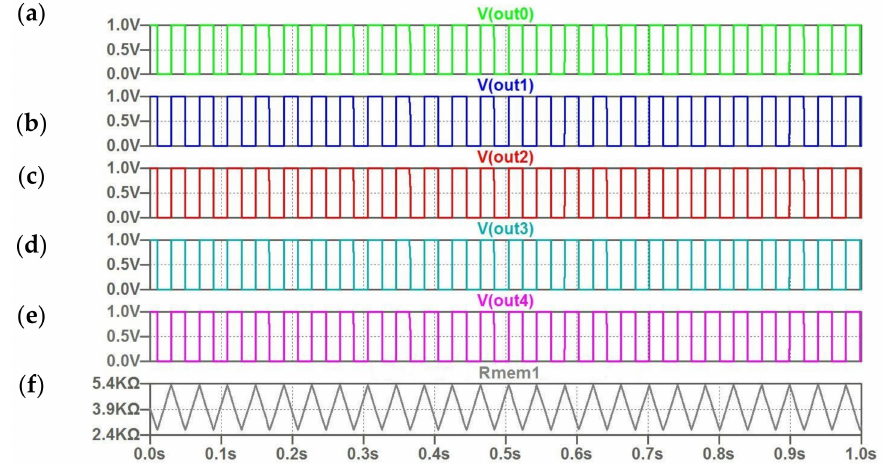
Figure 9. ( a – f ) The computed waveforms for five coupled oscillators for the “correct” image; ( f )–the triangular character of change memristor resistance R (t) for the first oscillator.